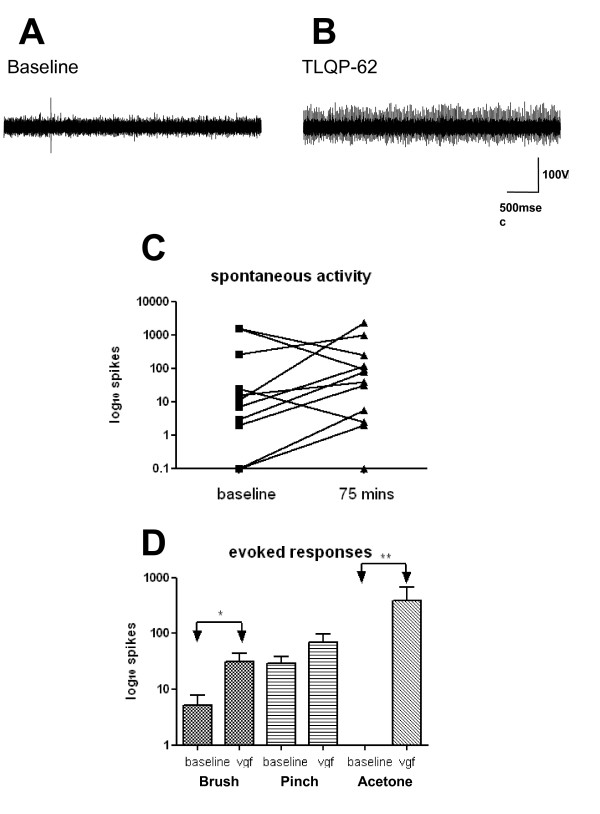
The effect of spinal TLQP-62 (50 nM) application upon L4/L5 dorsal horn cell activity in intact anaesthetized rats. A & B. A dorsal horn cell that had very little spontaneous spike activity at baseline, developed very high frequency spontaneous firing, shown here 50 mins post TLQP-62. C. The effect of spinal TLQP-62 application upon spontaneous activity in individual dorsal horn cells. The number of action potentials over a 10 min period is shown at baseline and at 75 mins post TLQP-62. The logarithmic scale reflects the very intense effect of TLQP-62 in a subpopulation of cells. D. The effect of spinal TLQP-62 upon brush, pinch and acetone evoked activity in dorsal horn cells (n = 14). The mean number of action potentials evoked by each stimulus (duration 1.5 secs) is shown at baseline and at 75 mins post TLQP-62. *P < 0.05, **P < 0.001 ; Mann-Whitney U test).